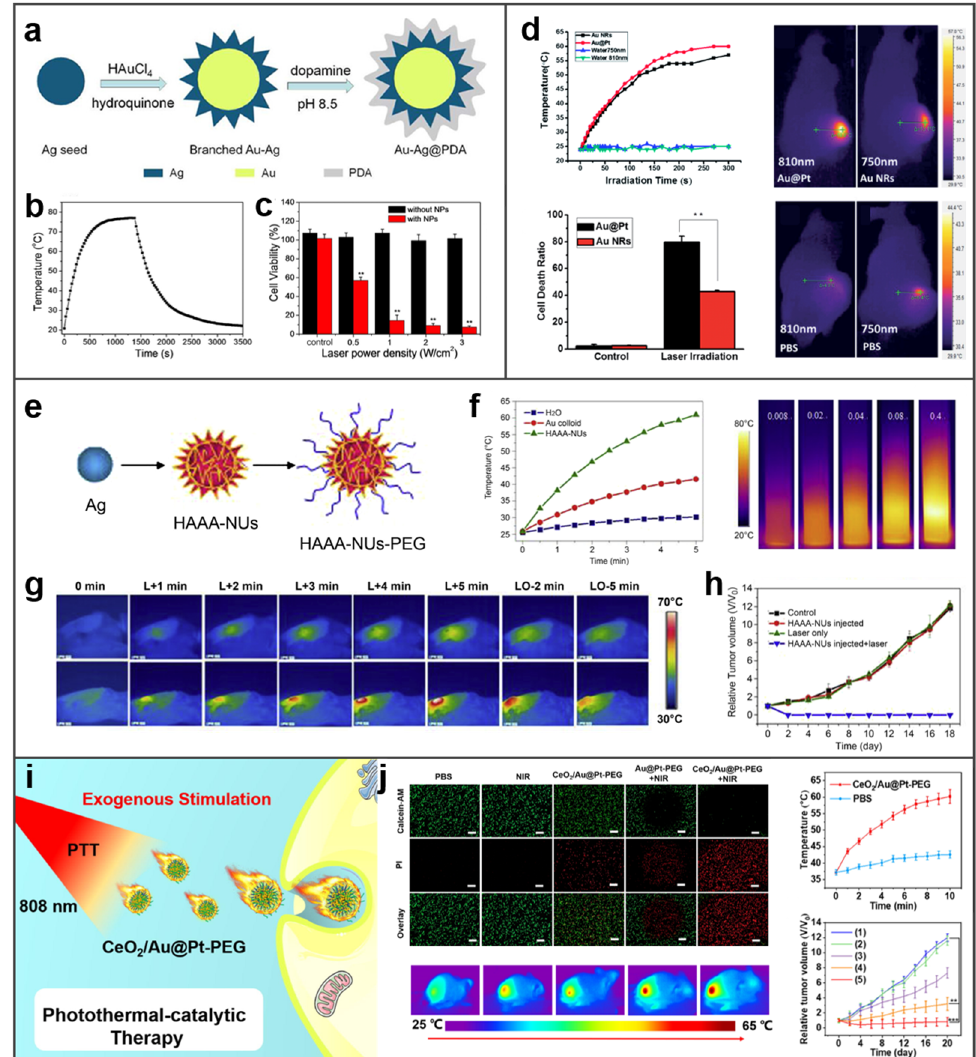
Figure 11. BMNs for photothermal therapy. ( a ) Schematic diagram of composition of Au–Ag@PDA. Reprinted with permission from Ref. [126]. ( b ) The temporal temperature variation of the branched Au–Ag NPs. Reprinted with permission from Ref. [126]. ( c ) Hela cell viabilities after 808 nm laser irradiation with different power densities for 10 min. Reprinted with permission from Ref. [126]. Copyright © 2015 American Chemical Society. ( d ) The photothermal therapeutic of Au@Pt nanostructures. Reprinted with permission from Ref. [127]. Copyright © The Royal Society of Chemistry 2014. ( e ) Strategy for HAAA-NUs synthesis and functionalization. Reprinted with permission from Ref. [128]. ( f ) Photothermal effect of HAAA-NUs. Reprinted with permission from Ref. [128]. ( g , h ) In vivo photothermal tumor therapy (( g ) IR thermal images of tumor-bearing mice with laser irradiation, L-laser on, LO-laser off. ( h ) The tumor volumes after different treatments). Reprinted with permission from Ref. [128]. Copyright © 2014 Elsevier Ltd. ( i ) Synergistic photothermal-catalytic therapy of CeO 2 /Au@Pt-PEG. Reprinted with permission from Ref. [129]. ( j ) The therapeutic effect of CeO 2 /Au@Pt-PEG on tumors in vitro and in vivo (Relative tumor volume: (1) PBS, (2) NIR,